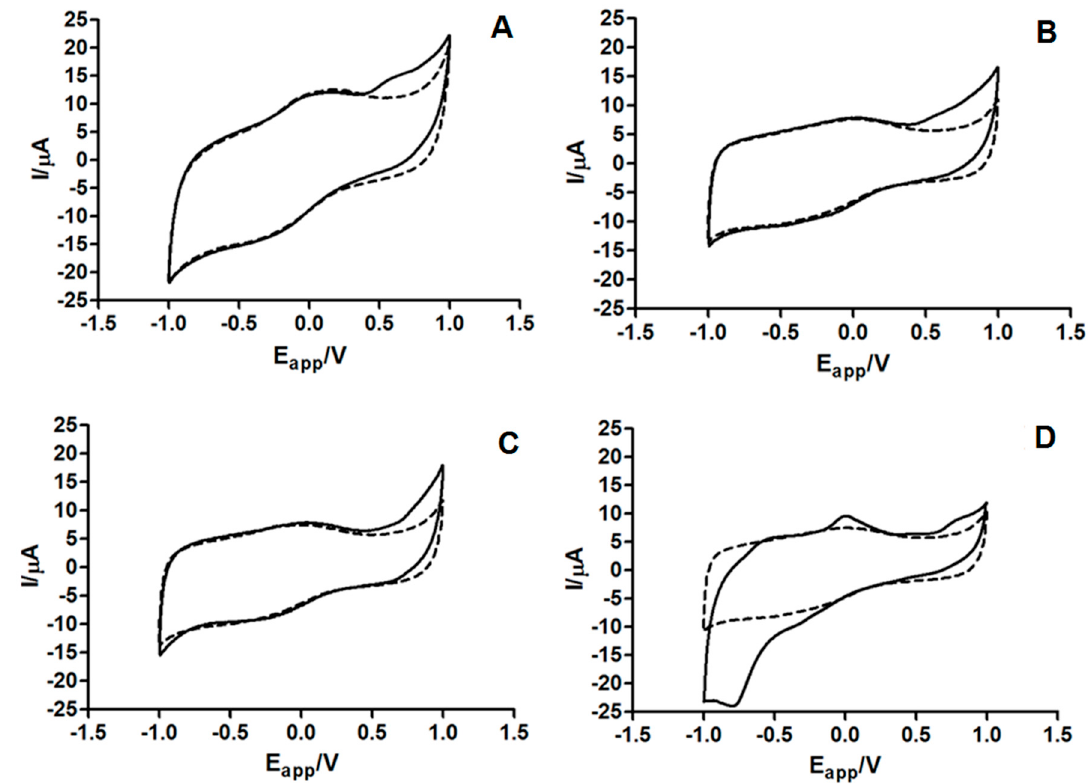
Figure 5. Cyclic voltammograms of SNAP ( A ), PI ( B ), 4-OMe-PI ( C ) and 4-NO 2 -PI ( D ). All experiments were carried out in fresh PBS/DMEM (10%), in the dark, at 37 °C. All voltammograms were recorded in the potential range ±1.0 V vs. Ag/AgCl, using a scan rate of 250 mV s − 1 . Voltammograms shown compare the current from PBS (dashed line) with that of PBS with 1 mM of the respective NO-donor (continuous line).